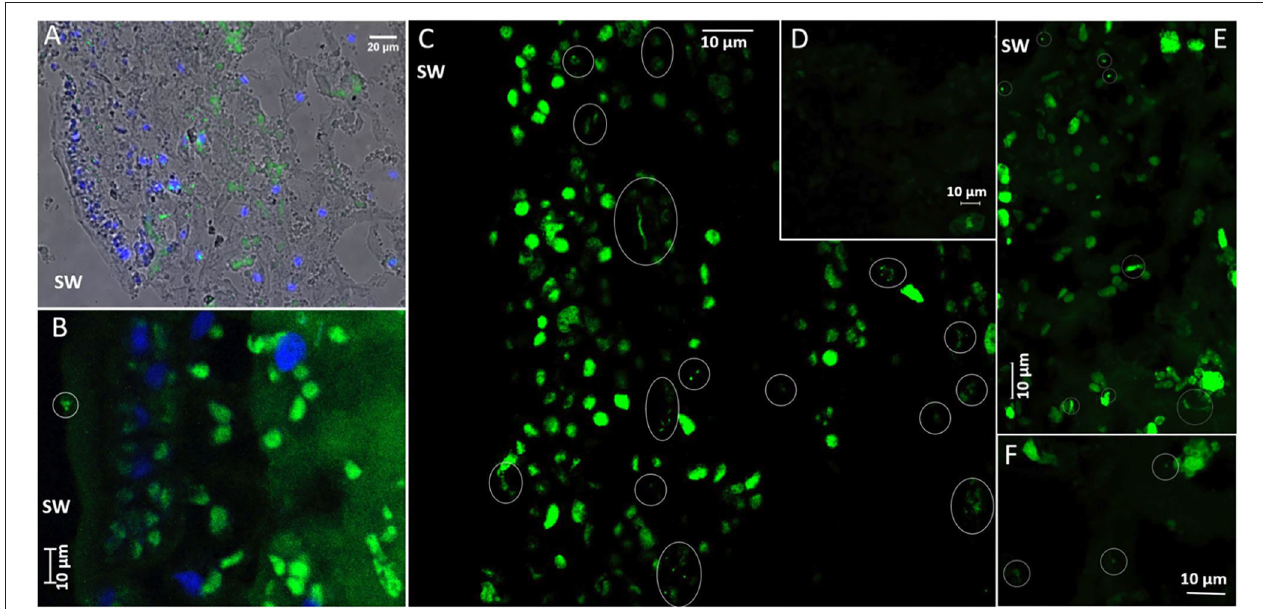
FIGURE 5 | CARD-FISH visualization of bacteria in Saccharina latissima tissue. Ellipses mark the position of bacteria. (A) Overview of bacteria in S. latissima alga 3S1 (histological section 5 µ m), with overlayed Transmission, Dapi-stained nuclei (blue) and Alexa488 (green) EUBmix probe positive bacteria in wide-field epifluorescence microscopy (Nikon Eclipse TE300, x40 oil objective). (B) A few bacteria at the surface of S . latissima alga 2S2 (histological section slide L2), imaged with Zeiss LSM880 in conventional mode (Maximum Intensity Projection of 1.5 µ m Zstack series with 0.5 µ m step increments). Chloroplasts in the cortex (with distinctive larger shape)